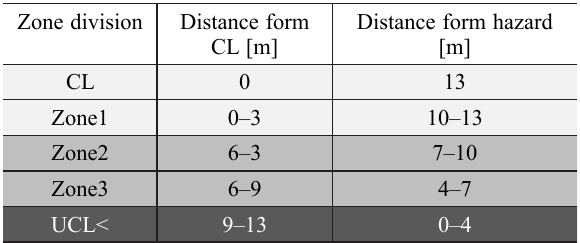
Table 1. Statistical zone